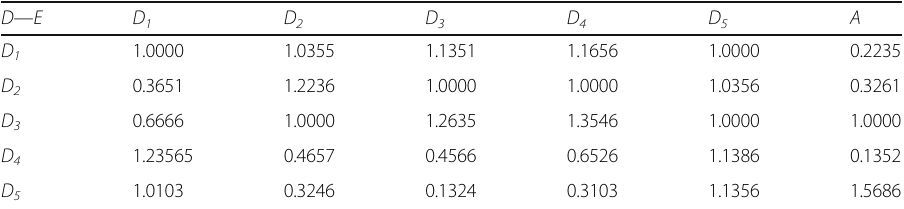
Table 3 Judgment matrix D -